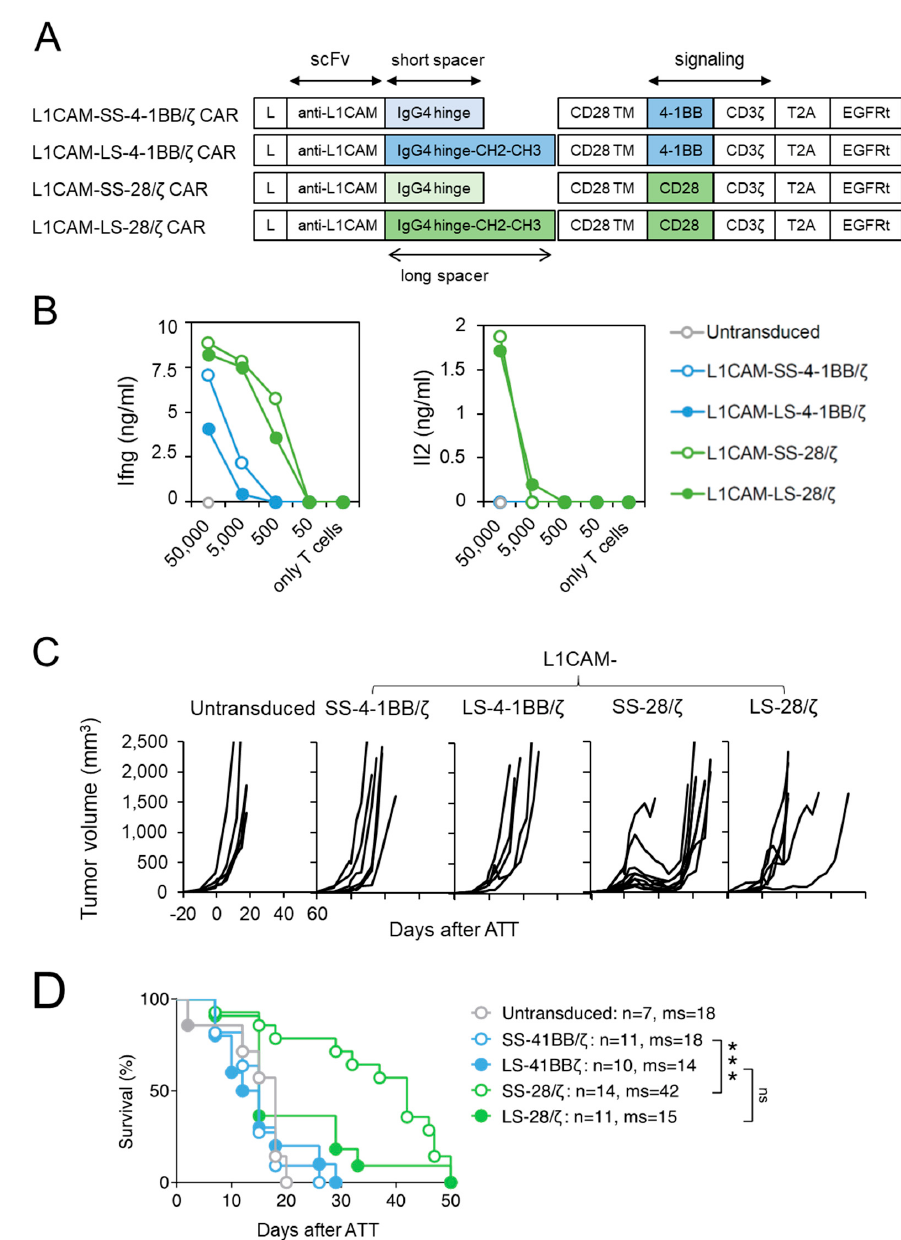
Figure 1. Murine CD8 + T cells expressing short spacer L1CAM-specific CARs with CD28/ ζ signaling domain show superior anti-tumor activity in vivo. ( A ) Scheme of retroviral CAR T cell constructs used to generate L1CAM-specific second-generation CAR T cells harboring a short or long spacer with 4-1BB or CD28 signaling domain. L: leader sequence; TM: transmembrane domain; T2A: virus 2A self-cleaving sequence, EGFRt, truncated epidermal growth factor receptor. ( B ) CD8 + T cells derived from ChRLuc/OT-1/Rag − / − transduced with indicated CAR constructs were co-cultured with titrated numbers of SK-N-BE(2) target cells for 24 h. Levels of secreted cytokines were measured by Ifng and Il2 ELISA. Shown is one representative experiment of three. ( C ) Tumor growth curves of SK-N-BE(2) tumor-bearing Rag − / − mice treated with 1 × 10 6 EGFRt + ChRLuc/OT-1/Rag − / − CAR T cells transduced with L1CAM-SS-4-1BB/ ζ ( n = 6), L1CAM-LS-4-1BB/ ζ ( n = 5), L1CAM-SS-28/ ζ ( n = 9), L1CAM-LS-28/ ζ ( n = 6) or with untransduced T cells ( n = 5) at indicated time-point. Each line represents change in tumor volume of an individual mouse over the period of the experiment. Data are representative of two independently performed experiments. ( D ) Kaplan–Meier survival analysis is shown from total mice for each indicated CAR T cell treatment. Combined data from two experiments are shown. Statistical significances are indicated as ***, p ≤ 0.005. ns = not statistically significant, SS = short spacer, LS = long spacer, ATT = adoptive T cell transfer, ms = median